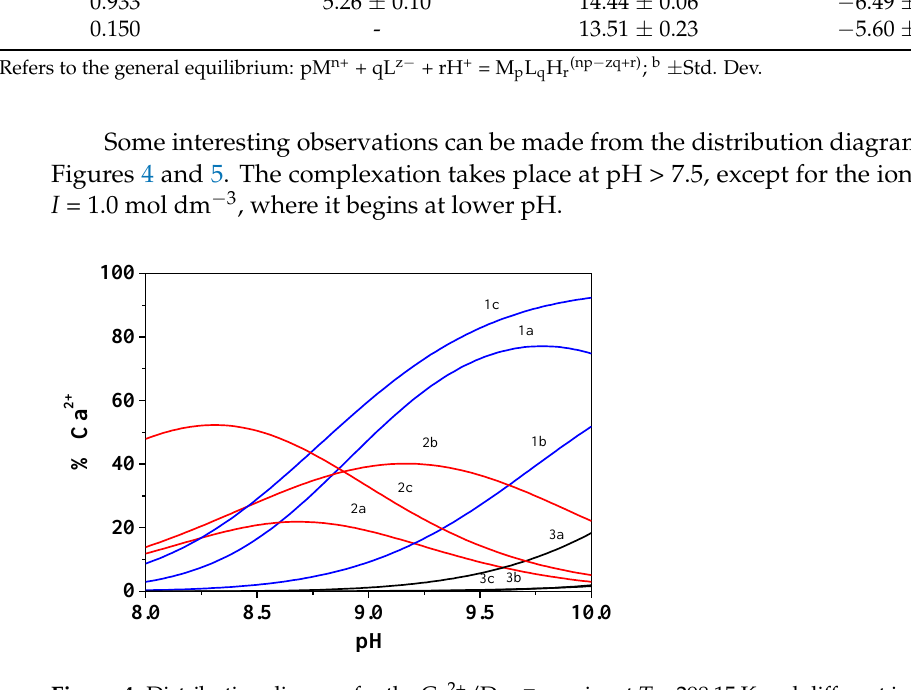
Figure 4. Distribution diagram for the Ca 2+ /Dop − species at T = 298.15 K and different ionic strengths. Species: 1 ML; 2 MLH; 3 MLOH. a: I = 0.143 mol dm − 3 ; b: I = 0.472 mol dm − 3 ; c: I = 0.933 mol dm − 3 . (Experimental conditions: c Ca2+ = 1.5 mmol dm − 3 ; c DOP − = 5 mmol dm − 3 ) [M = Ca 2+ ; L = Dop − ].